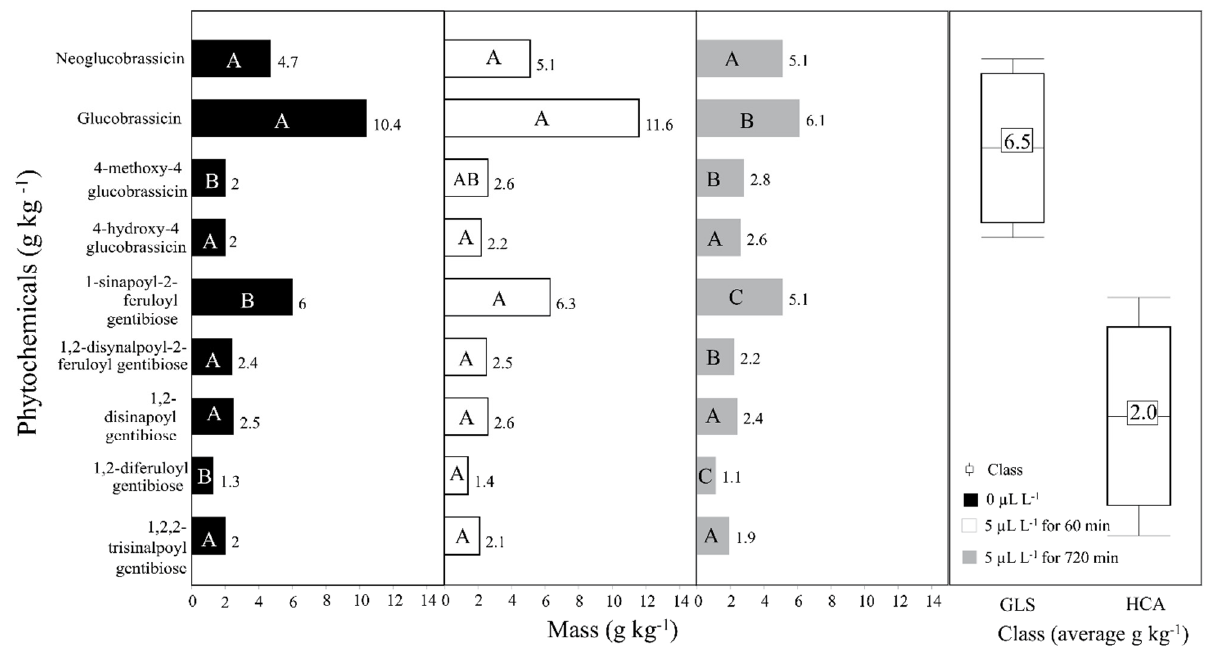
Figure 4. Ozone effect on individual glucosinolates and hydroxy-cinnamic acids. Florets were treated with O 3 with 0 µ L L − 1 , 5 µ L L − 1 for 60 min (hormetic dose), and 5 µ L L − 1 for 720 min (high dose), and stored for 14 days at 4 ◦ C. Values are g equivalents of sinigrin on a dry weight basis ± SD ( n = 3), and are the averages of 0, 7, 14, and 21 days. g kg − 1 . Different letters in each of the rows show significant differences ( p < 0.05) between treatments according to Student’s t-test for each pair.